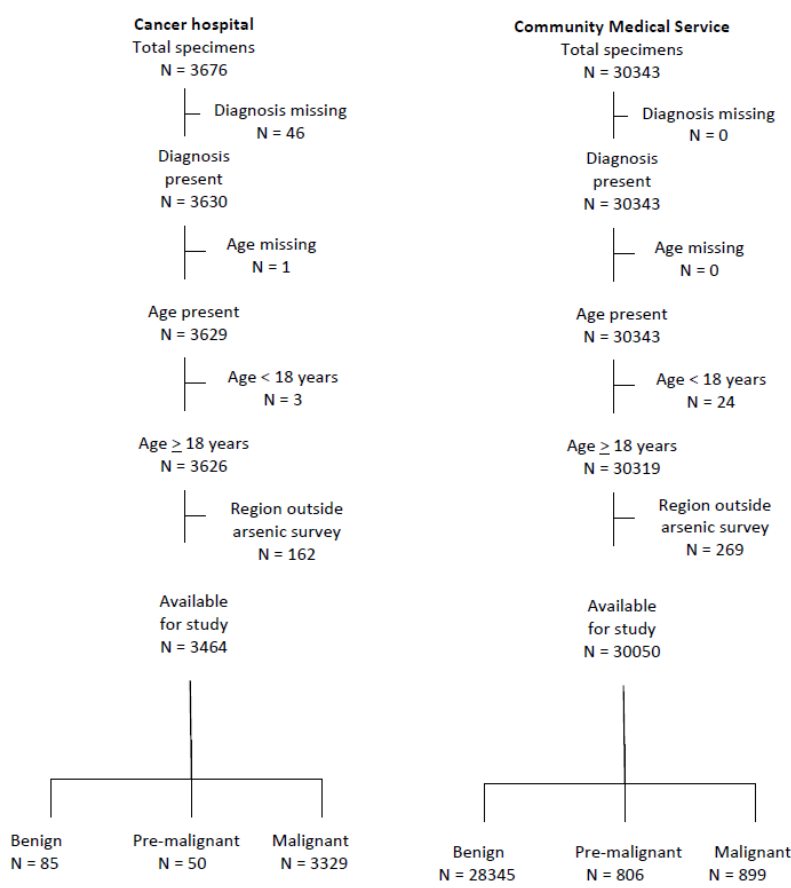
Figure 1. Study population.